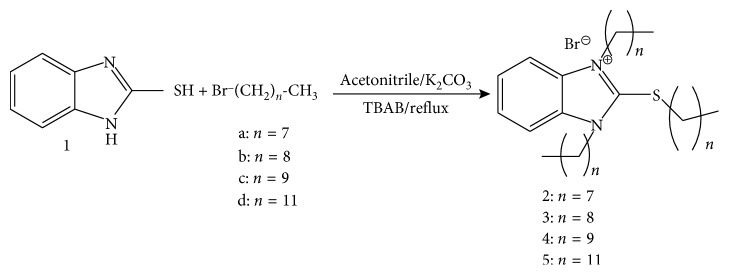
Synthesis of 1,3-dialkyl-2-alkylthio-1H-benzimidazolium bromides 2–5.